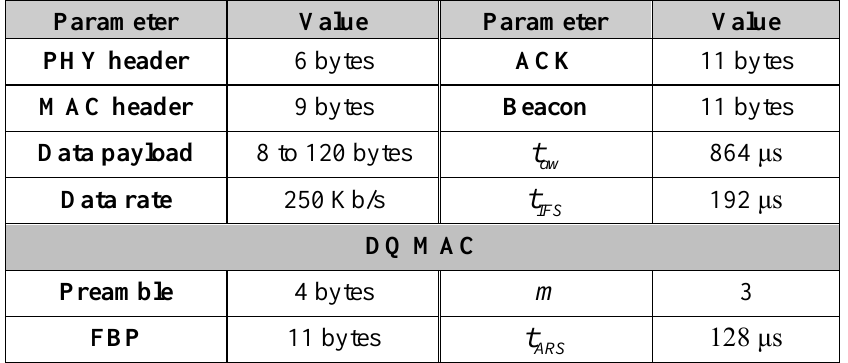
Table 2. IEEE 802.15.4 MAC & DQ MAC Parameter